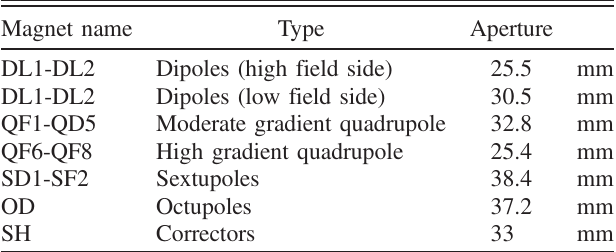
TABLE II. Magnet apertures: central gaps for dipoles and bore diameter for higher order multipoles. The QF1-QD5 moderate gradient quadrupoles have 2.5 to 2.9 mm pole chamfers. All other magnets have straight poles.